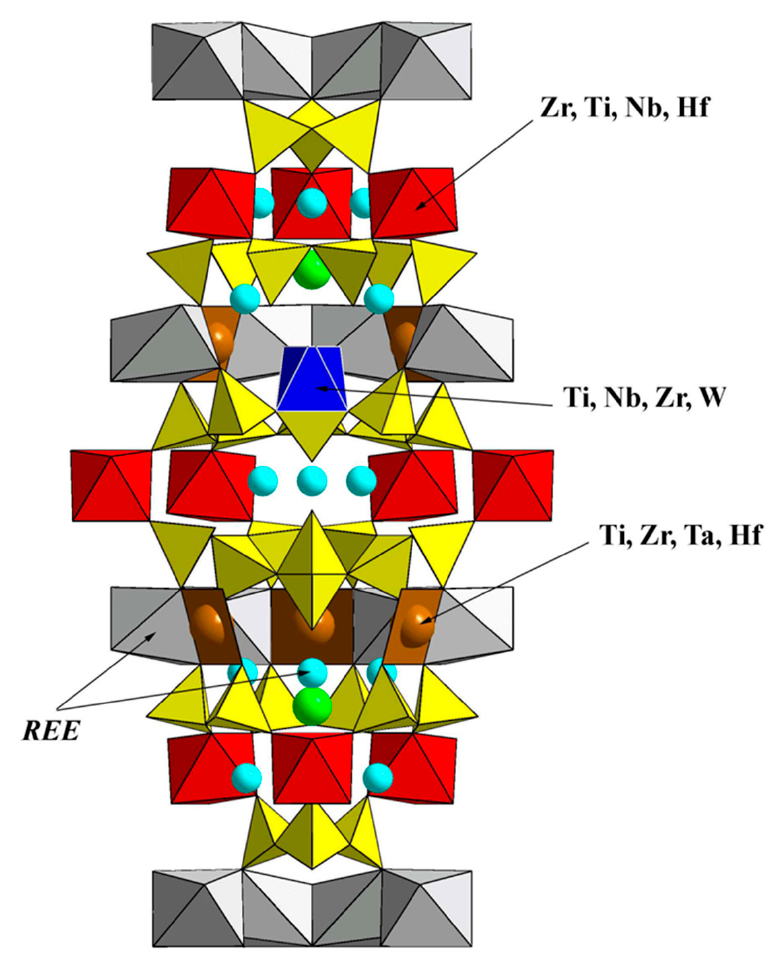
Figure 1. The general view of the crystal structure of EGMs and the distribution of RMs and REMs over the different crystallographic sites.